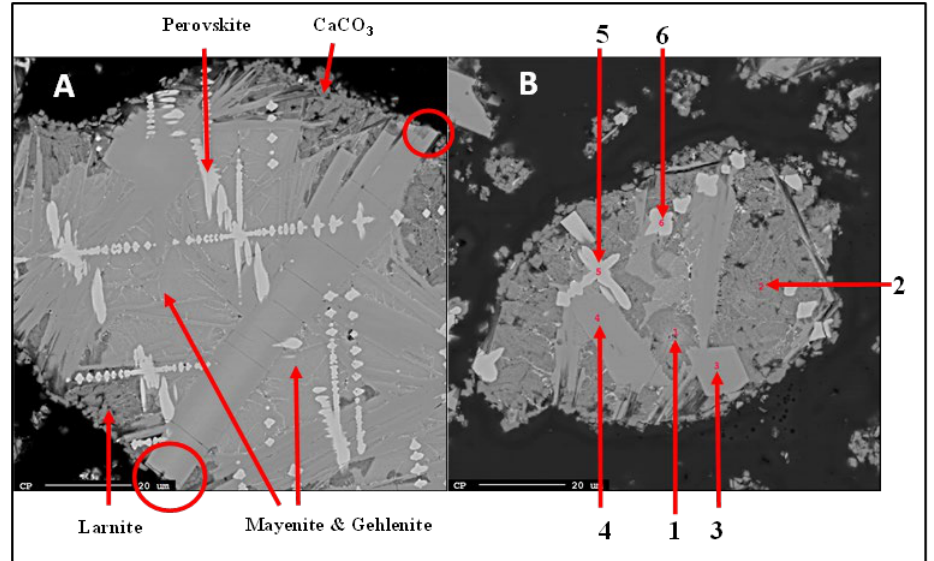
Figure 12 . ( A ) Image from grey mud sample test no. 1. ( B ) Elemental quantification on grey mud sample test no. 3. Points 1 and 2 (mayenite), points 3 and 4 (gehlenite), points 5 and 6 (perovskite).